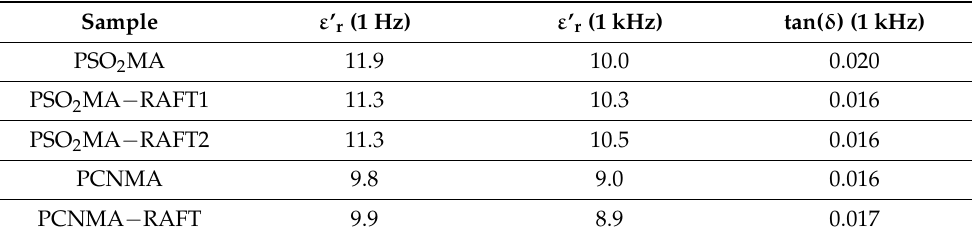
Figure 7. Evolution of ε ’ r , ε ” r , and tan( δ ) with the temperature at different frequencies for PCNMA and PCNMA − RAFT. Table 4. ε ’ r and tan( δ ) values measured at 25 ◦ C for polymethacrylates prepared by conventional radical polymerization and